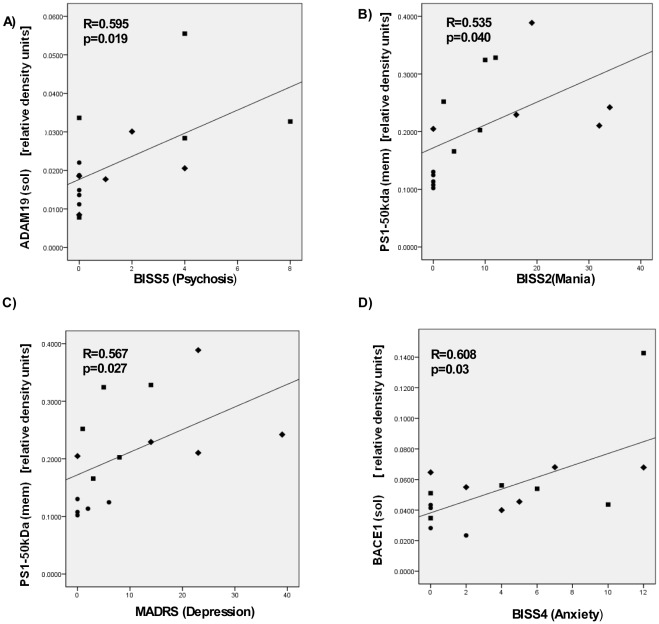
Pearson’s correlation analyses between levels of NRG1 cleavage enzymes and symptomatology criteria.A, B, C) BA9; D) hippocampus; A) ADAM19 and BISS5 (Psychosis); B) Presenilin-1 (PS1)-50 kDa and BISS2 (Mania); C) PS1-50 kDa and MADRS (Depression); D) BACE1 and BISS4 (Anxiety). Controls (•), SCZ (▪) and BPD (▴). R and p values were calculated based on symptomalogy score and protein expression, regardless of DSM diagnosis.